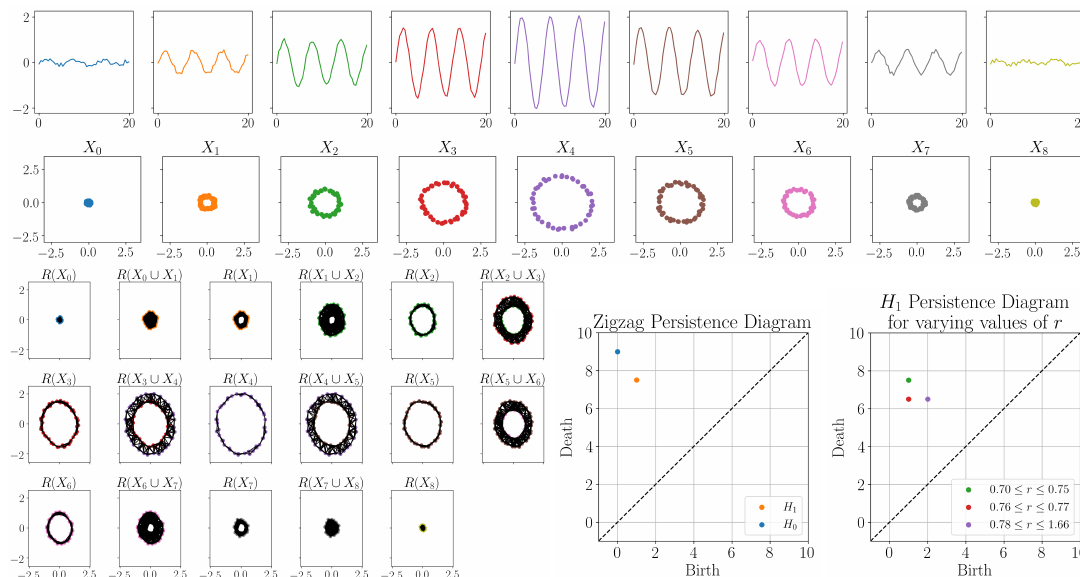
Figure 6. First and second rows : generated time-series data and corresponding time-delay embeddings. Bottom left : The zigzag filtration using Rips complex with fixed radius of 0.72. Note that 2-simplices are not shown in the complexes. Bottom middle : The corresponding zigzag persistence diagram. Bottom right : Persistence diagram showing how the 1-dimensional off diagonal point varies depending on the Rips complex radius parameter